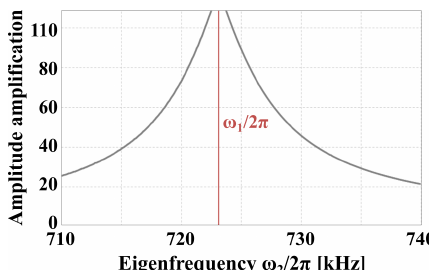
Figure 11. Amplification factor for the higher resonance peak of the coupled system for varying eigenfrequency ω 2 = 2 πf 2 of the nanocantilever. The eigenfrequency ω 1 = 2 πf 1 of the microcan- tilever is kept constant and is indicated by the vertical